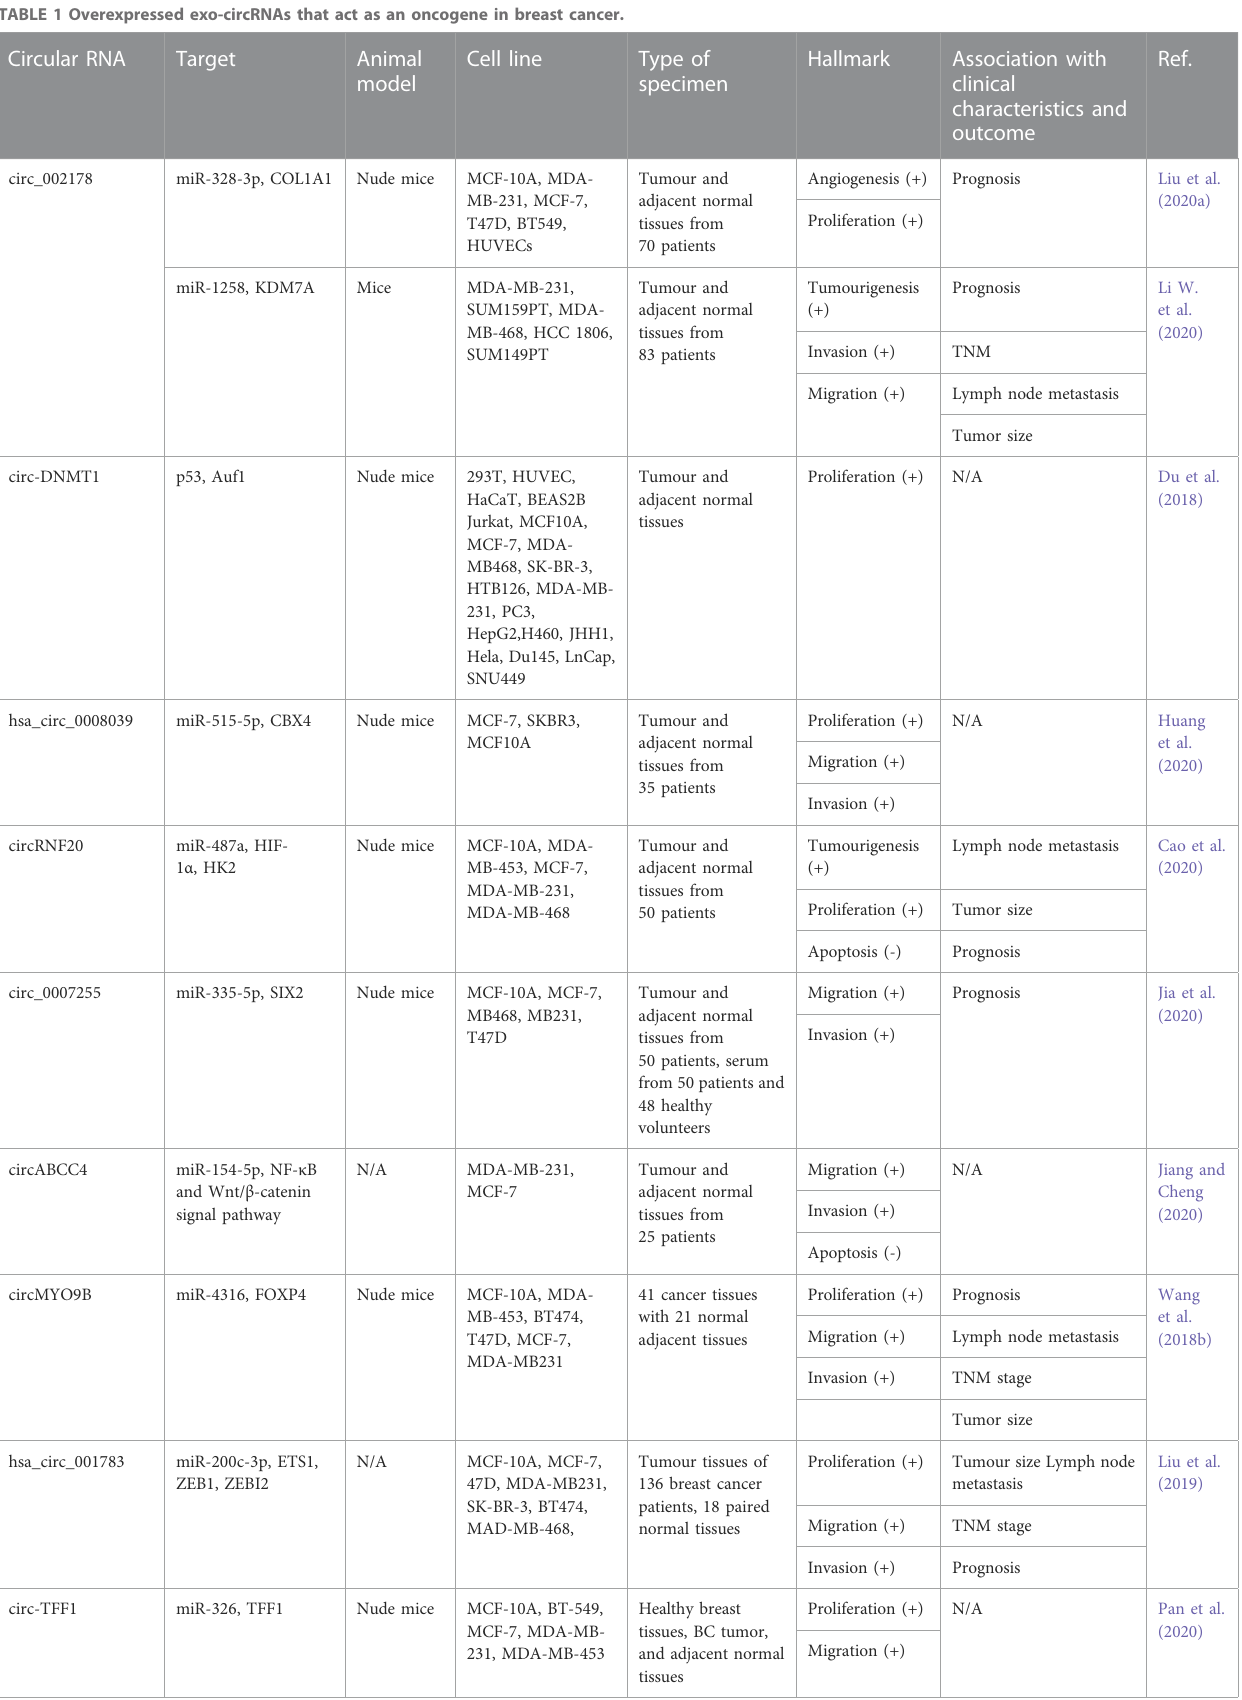
TABLE 1 Overexpressed exo-circRNAs that act as an oncogene in breast cancer. Circular